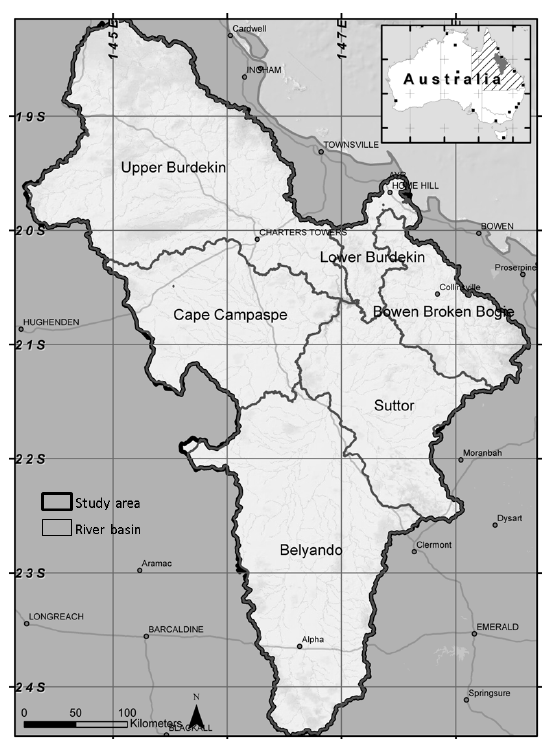
Figure 1. Location of the Burdekin Dry Tropics (BDT) region in the state of Queensland, Australia, the six major river basins, and major roads and